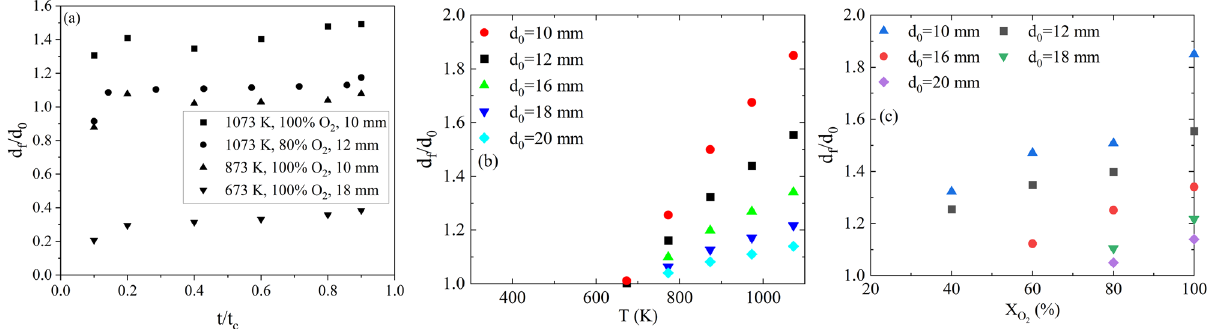
Figure 9. Variation of film diameter d f to initial particle diameter d 0 ratio with ( a ) Normalised conversion time ( b ) temperature (100% O 2 ) and ( c ) O 2 concentration (1073 K) (error associated with the determination of d f is < 0.05